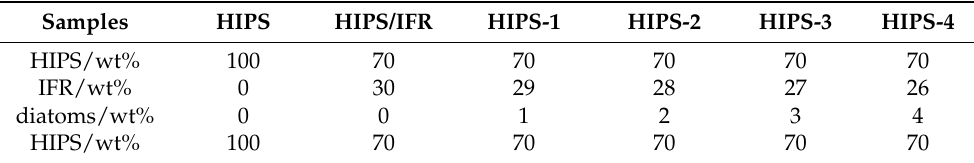
Table 1. The formula of the IFR/diatoms/HIPS flame retardant compounds.